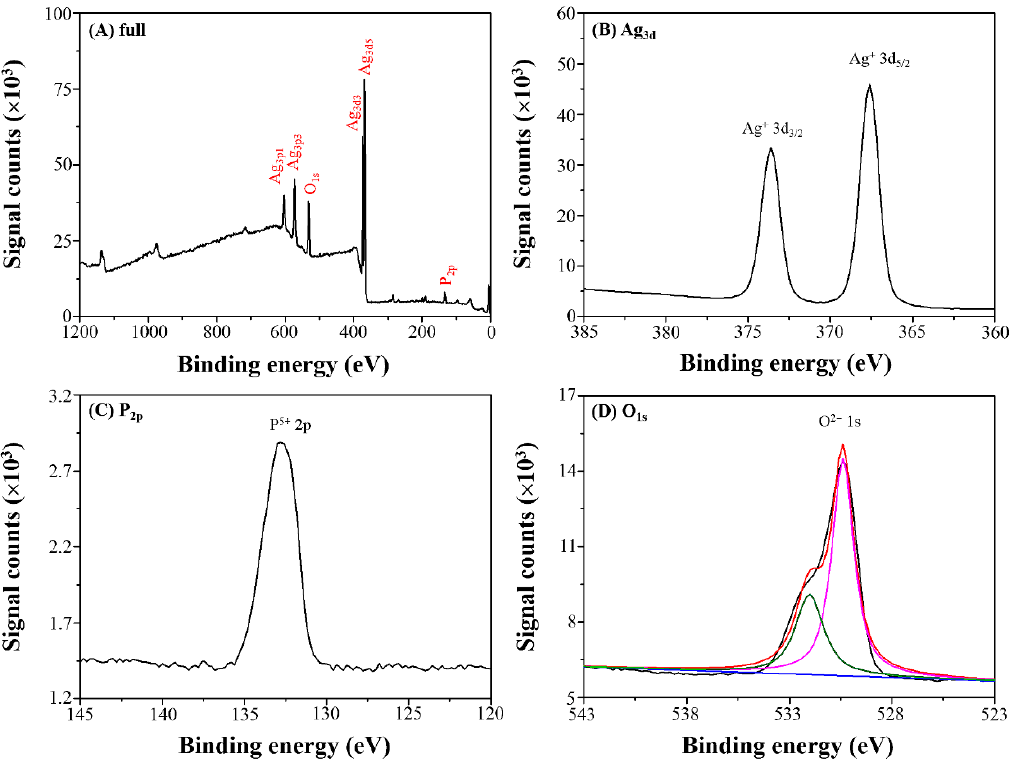
Figure 6. XPS spectra of Ag 3 PO 4 : ( A ) full scan; ( B ) Ag 3d ; ( C ) P 2p ; and ( D ) O 1s . Deconvolution of XPS peak for O 1s element represented in different color line.